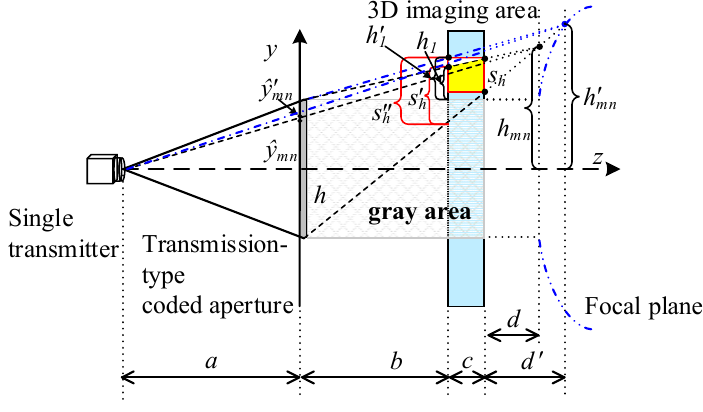
Figure 5. Schematic diagram of modified solution on y -PPMF.